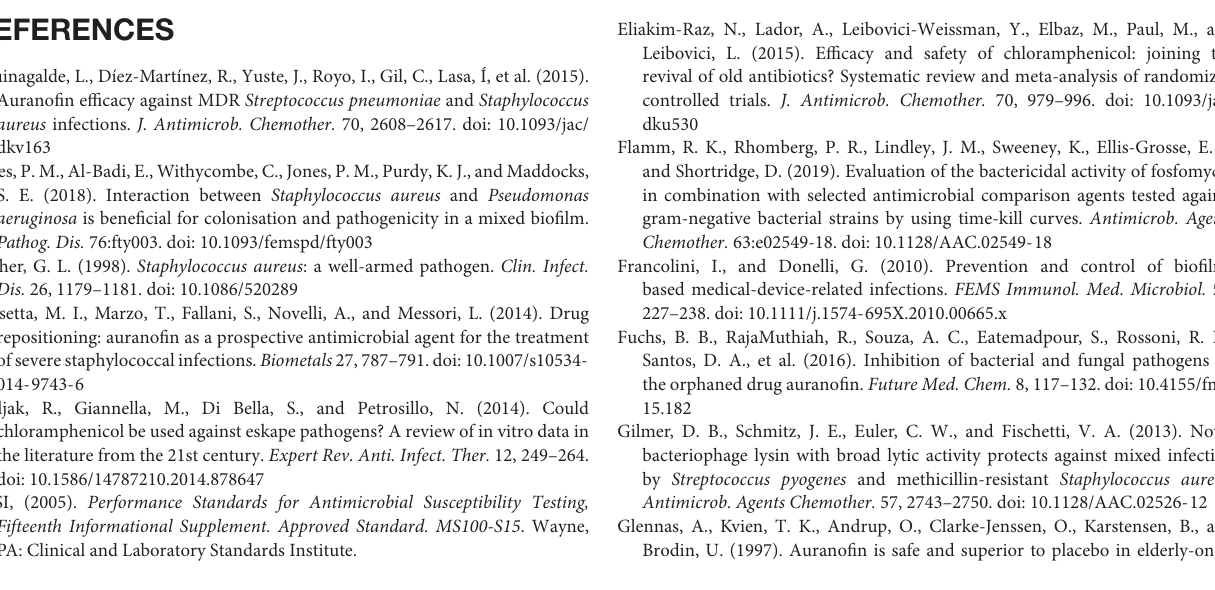
FIGURE S1 | Representative CLSM images of biofilm eradication by AF and FOF mono-/combination treatment. S. aureus LZB1 biofilms on the surfaces of cover slides were treated with AF (16 mg/L) and/or FOF (128 mg/L) as described in Section “Materials and Methods,” the stained with the SYTO9/PI fluorescent dye